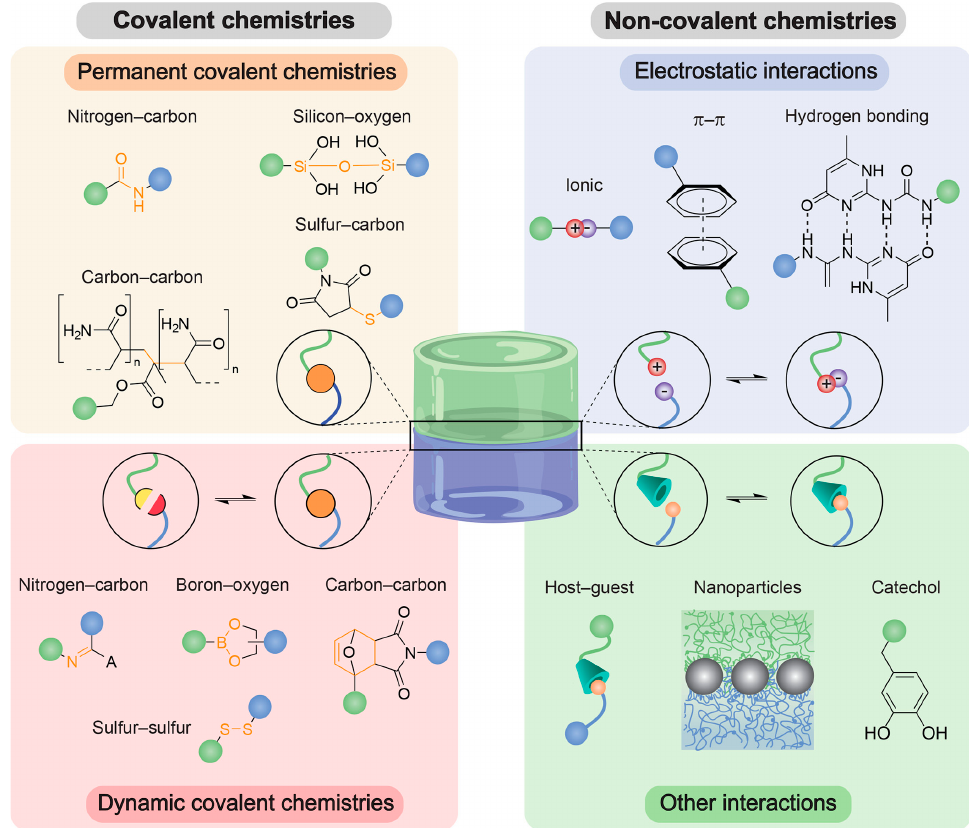
Figure 5. Overview of common bonds that are used as adhesion junctions. Adhesion junctions can be formed via permanent or dynamic covalent or noncovalent bond formation. Noncovalent interactions include electrostatic interactions and other interactions such as host–guest chemistries and polymer − nanoparticle (NP) interactions, for instance, catechol-based ones. Reprinted with permission from Ref. [7].